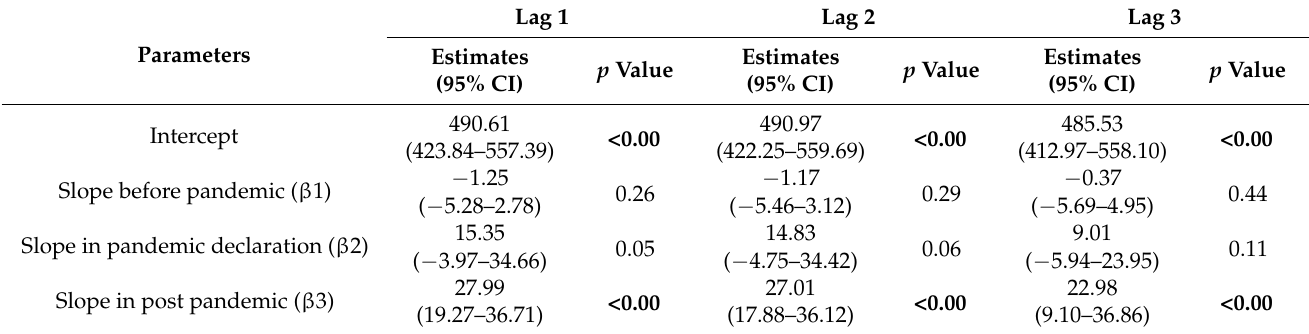
Figure 2. Monthly trends in the commencement of new oncology trials from 1 January 2018 to 28 February 2021. Table 2. Segmented regression analysis to assess time lag after pandemic